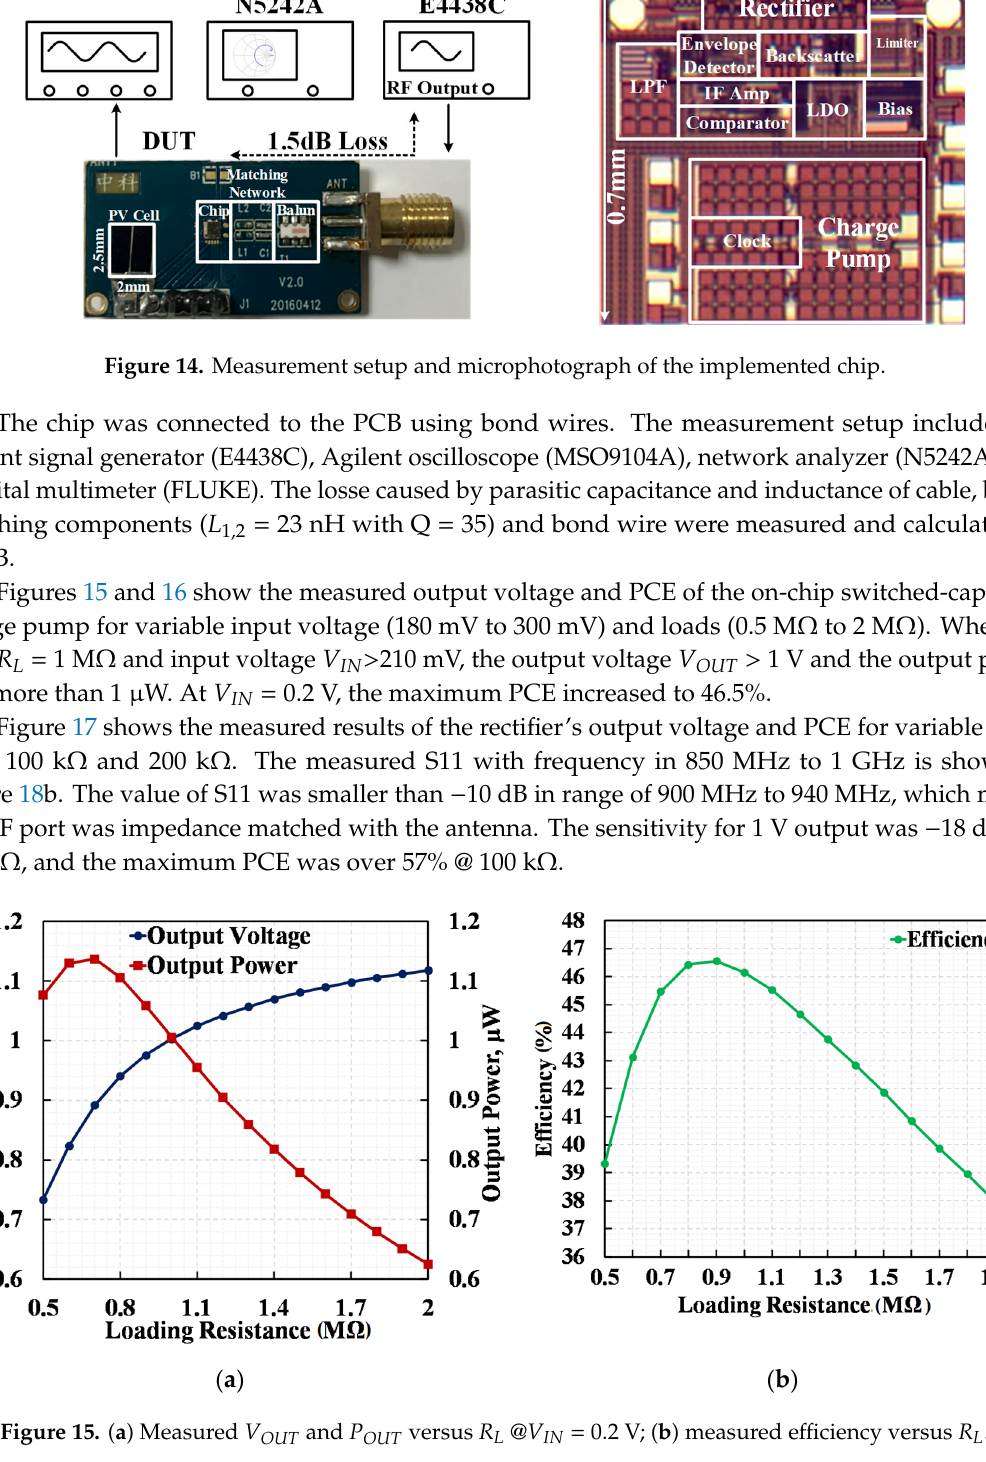
OUT and P OUT versus R L @ V IN